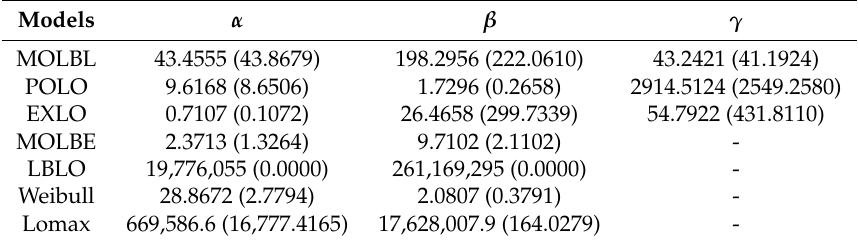
Table 14 indicates the values of the AIC, CAIC, BIC, HQIC, A ∗ , W ∗ , KS and p -value of the considered